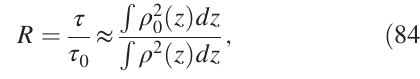
FIG. 19. Ratio of Touschek lifetime to that without HHC, with decreasing detuning. Distributed gaps with no guard